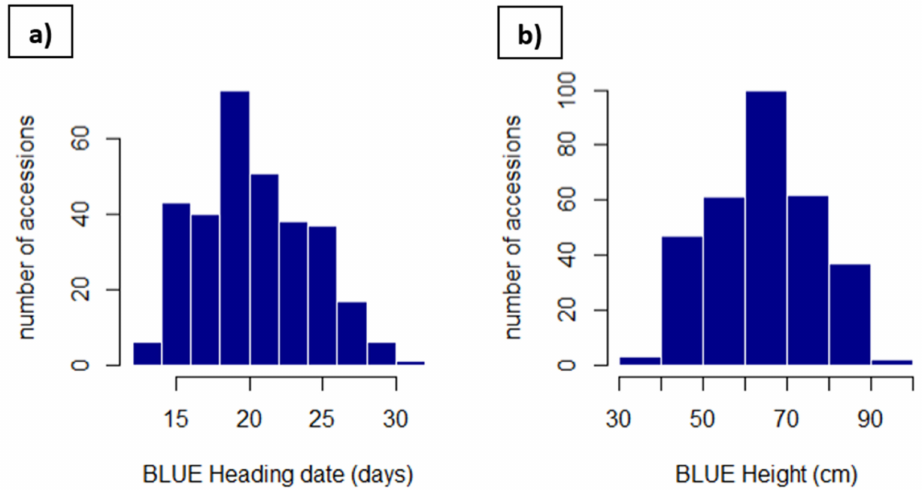
Figure 3. Histograms representing the distribution of the best linear unbiased estimator (BLUE) for ( a ) the heading date (measured in days from 1 May) and ( b ) plant height (measured in cm between the soil and the bottom of the spike).